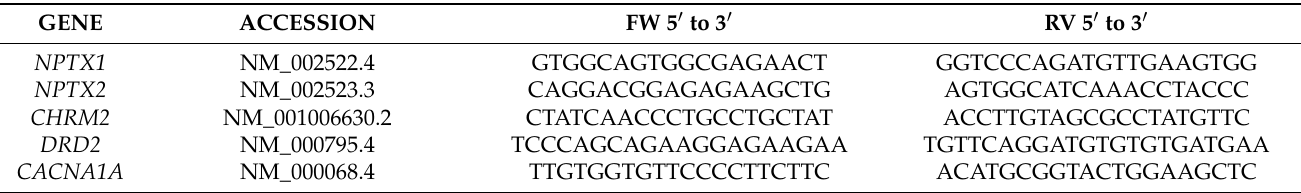
Table 2. Primer sequences and accession